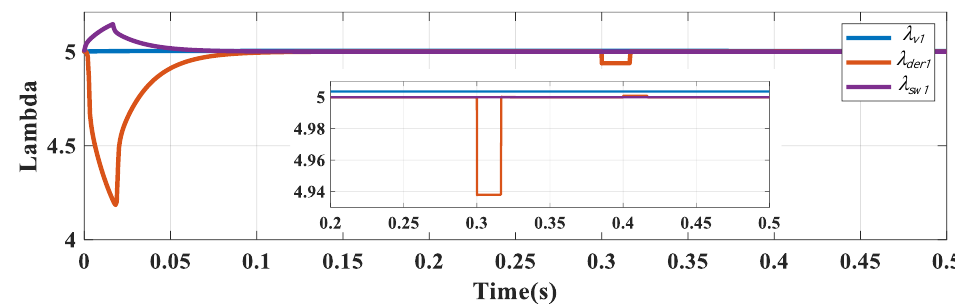
Figure 21. Study 3: generated weighting coefficients for FCS-MPC in DG1.